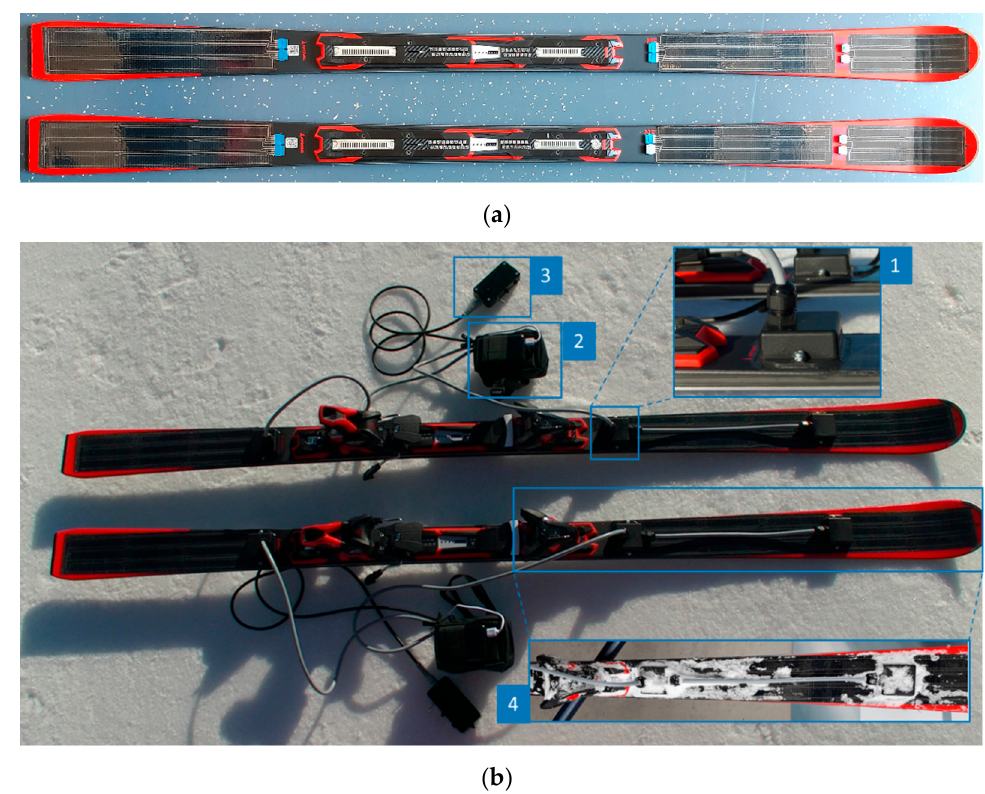
Figure 1. Ski prototype ( a ) after laminating the sensor foils and ( b ) after complete assimilation of all components. 1: Encased contact point that was sealed with silicone; 2: measurement data acquisition device (DAQ); 3: synchronization unit; 4: waterproof ski after system check.